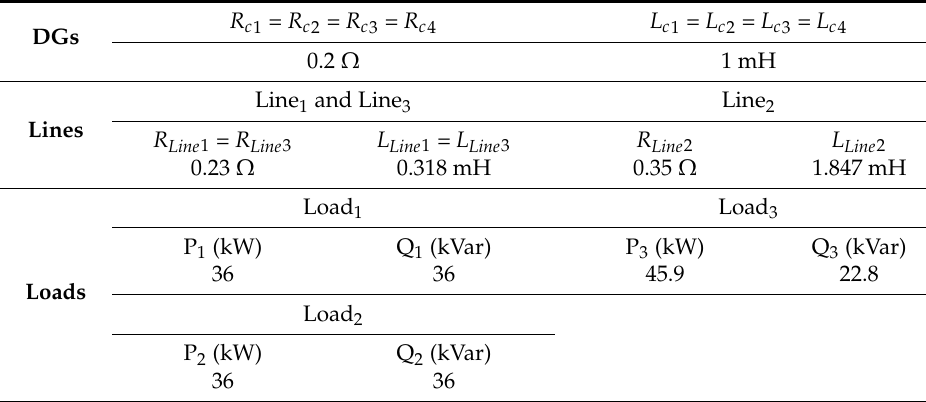
Table 1. Parameters of the MG